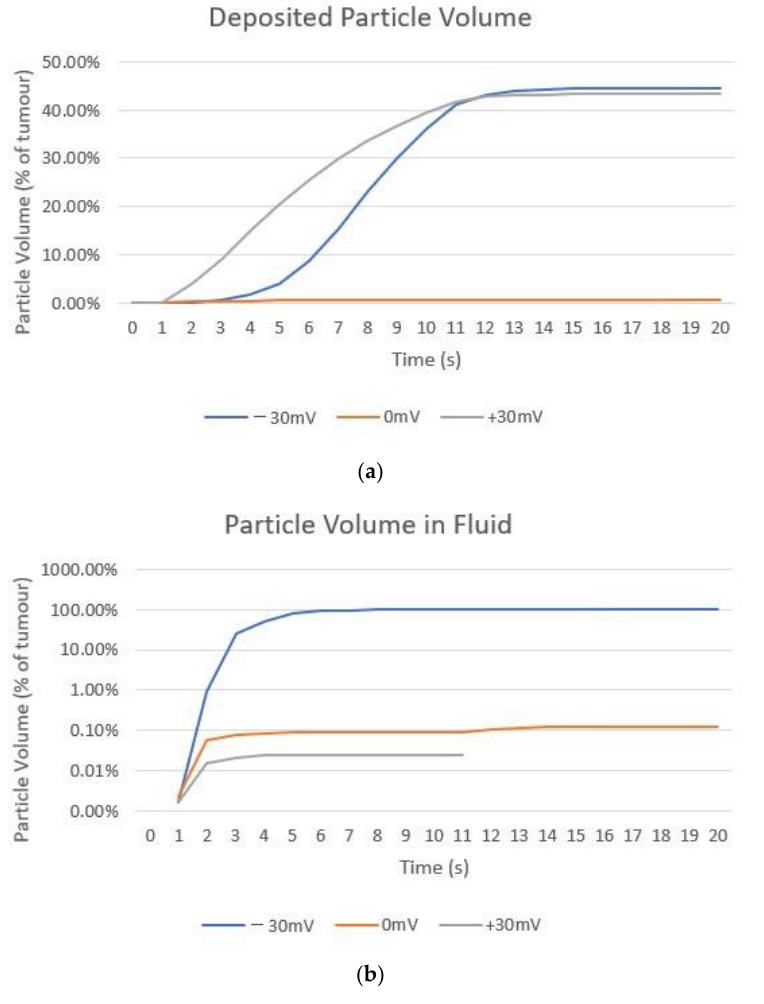
Figure 8. Change in the calculated volume of particles as a percentage of the total tumour volume from the start of injection to 10 s post-injection for all three surface charges: ( a ) deposited onto cell surfaces, threshold 1 × 10 −7 mol/m 2 ; ( b ) within the fluid, threshold 0.1 mol/m 3 .